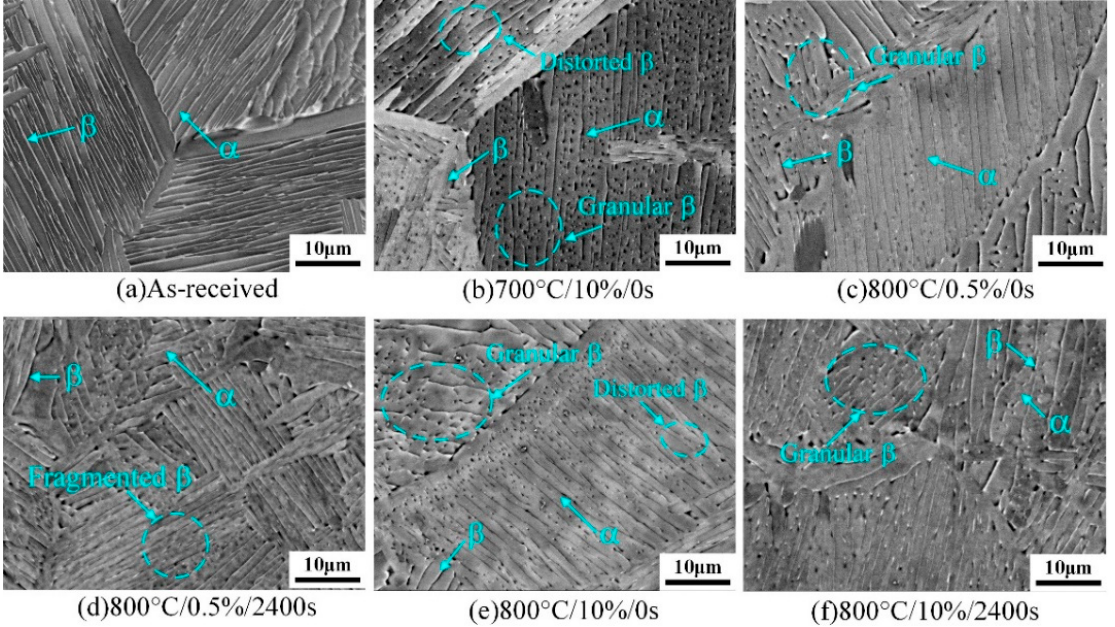
Figure 8. SEM observation showing the microstructure evolution of Ti-6Al-4V alloy at ( a ) as-received material, ( b ) 700 °C/10%/0 s, ( c ) 800 °C/0.5%/0 s, ( d ) 800 °C/0.5%/2400 s, ( e ) 800 °C/10%/0 s and ( f ) 800 °C/10%/2400 s.